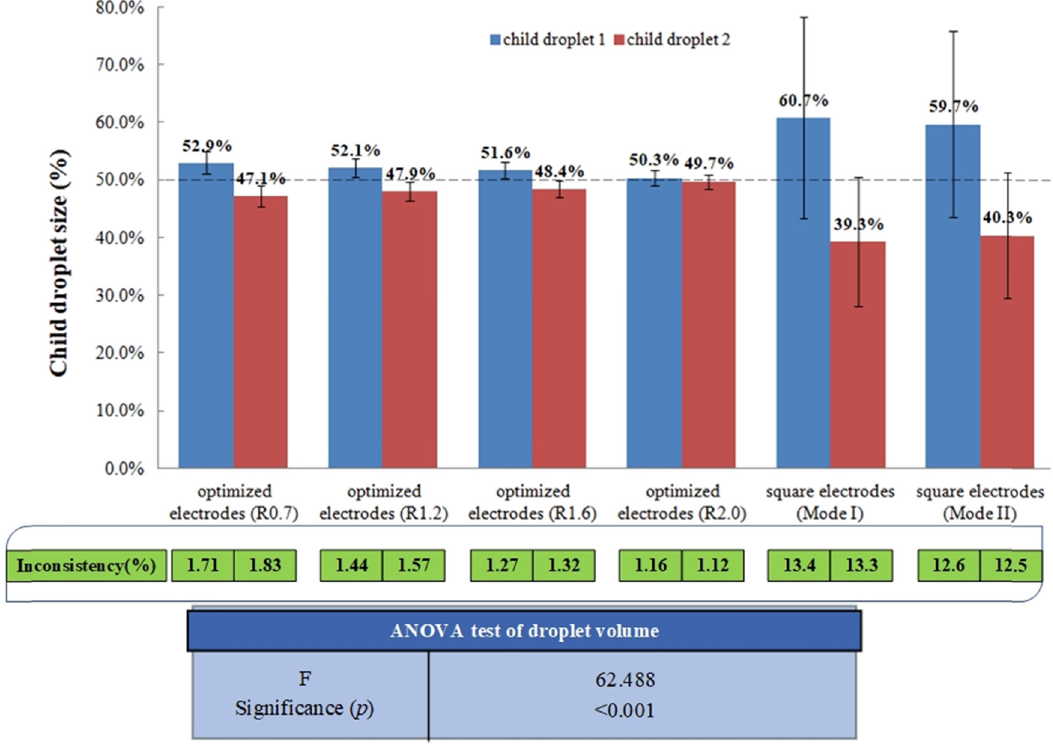
Figure 10: The volume of the child droplets for optimized splitting electrodes and traditional square splitting electrodes. The child droplet 1 refers to the larger one, while the child droplet 2 refers to the smaller